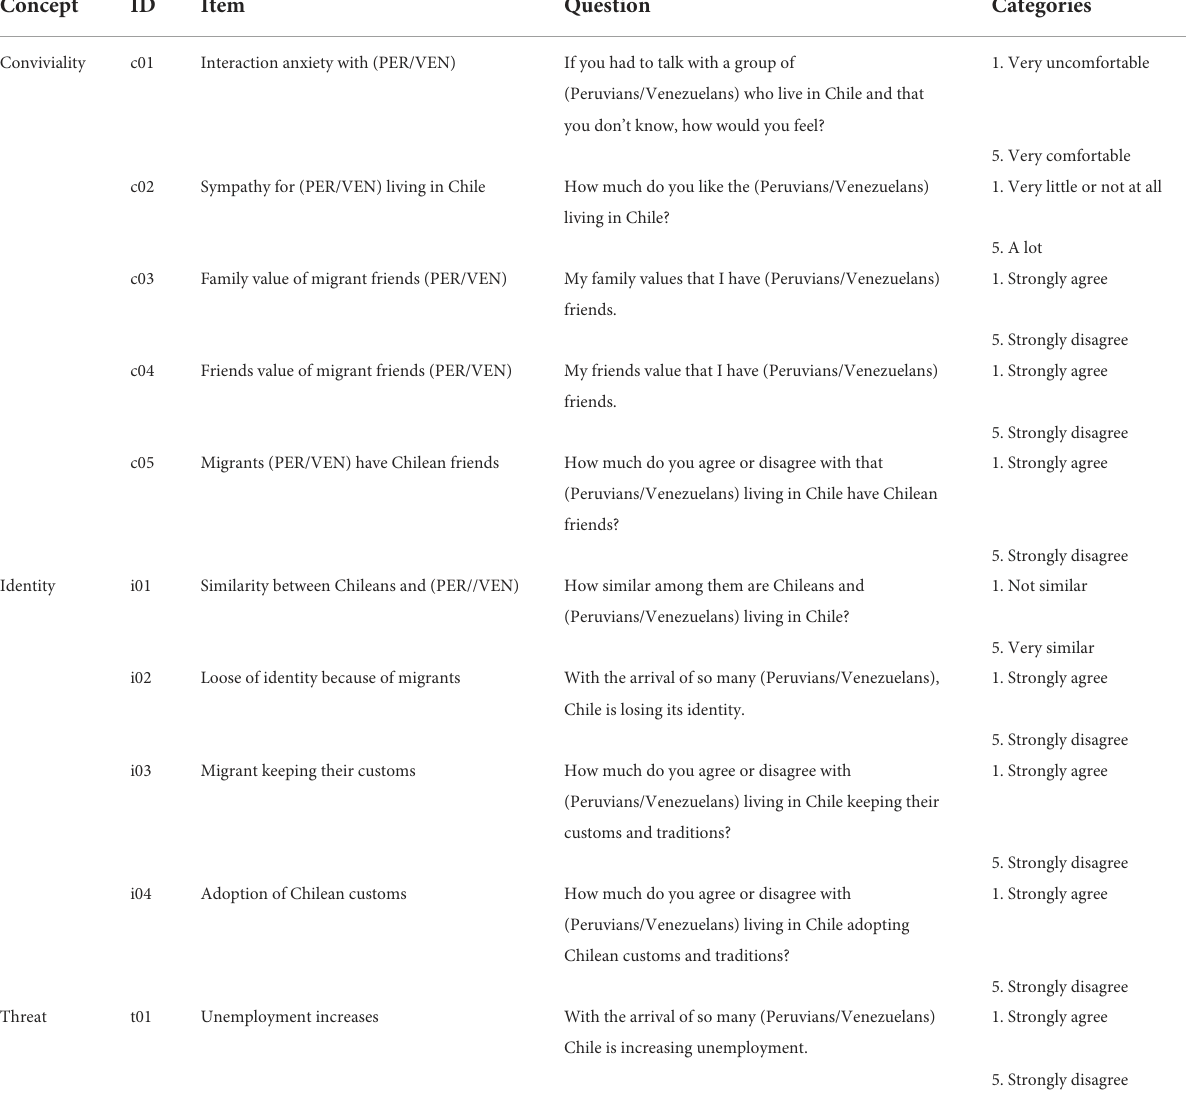
TABLE 2 Items for perceptions and attitudes toward